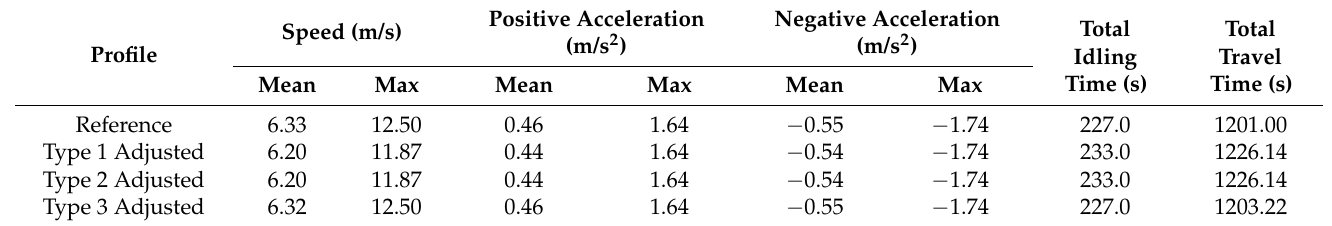
Table 5. Kinetic summary statistics of adjusted drive cycles (WMTC Cycle 2).